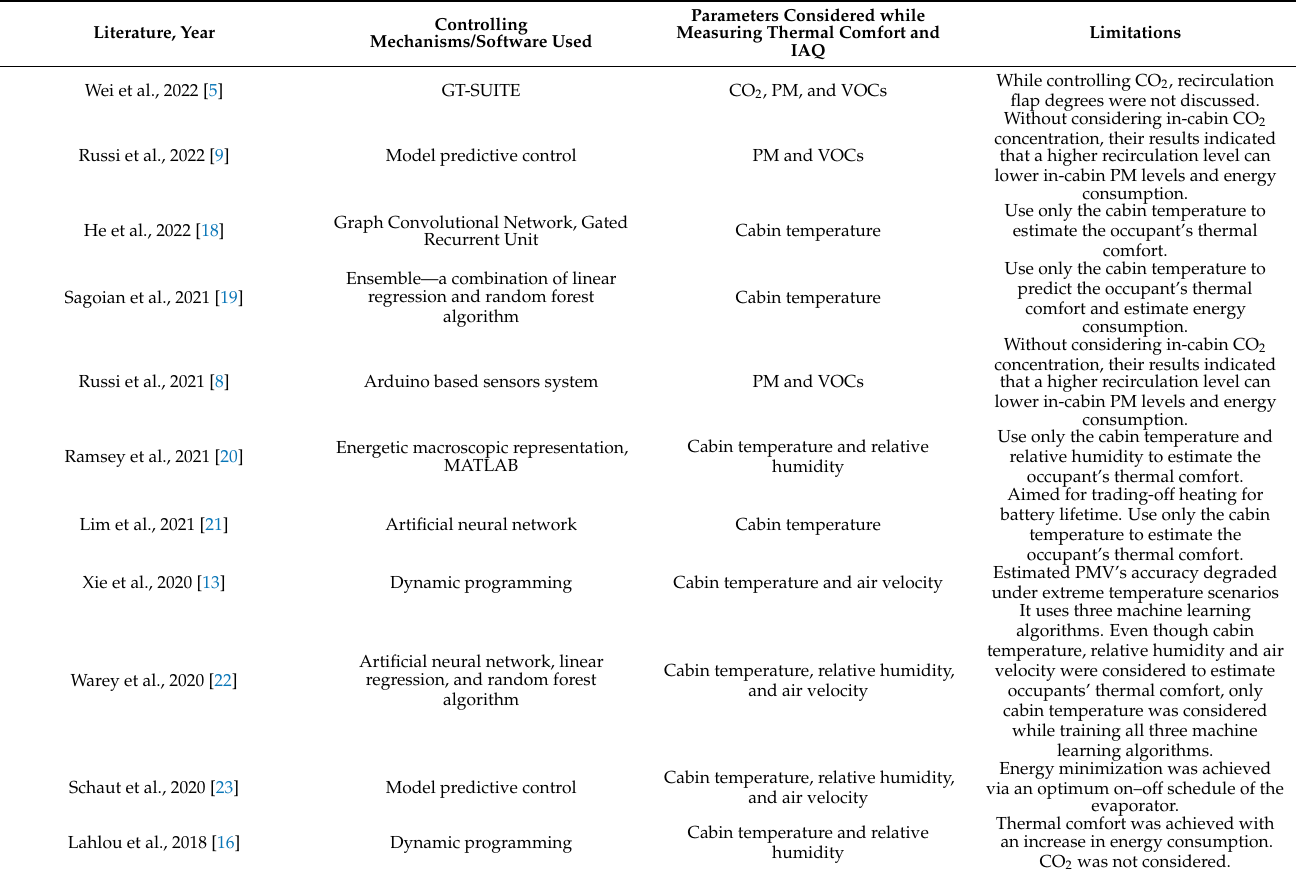
Table 1. Parameters of thermal comfort and IAQ incorporated in the studies of vehicle HVAC system controller designs over the past five